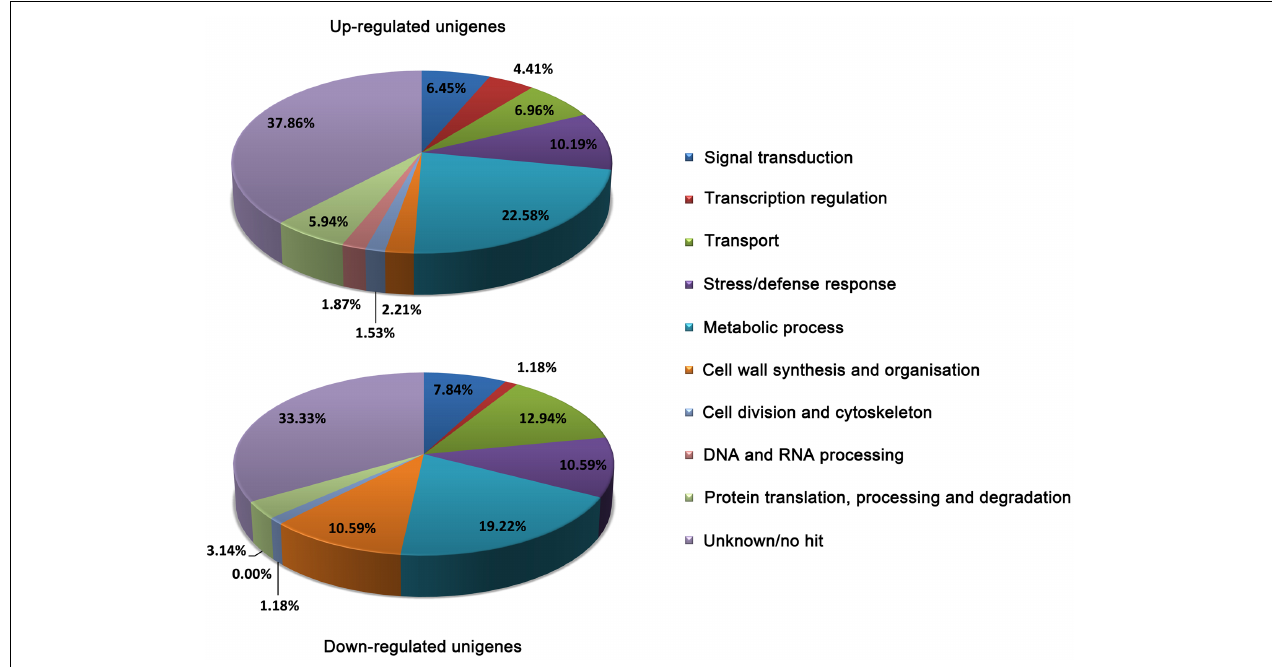
FIGURE 1 | Functional categories of up- and down-regulated DEGs. The classification was performed according to gene ontology (GO) biological process. The percentage of genes in each category was